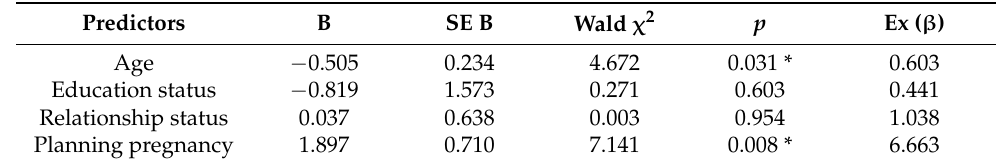
Table 5. Binomial logistic regression of demographic variables associated with social media use for pregnancy-related